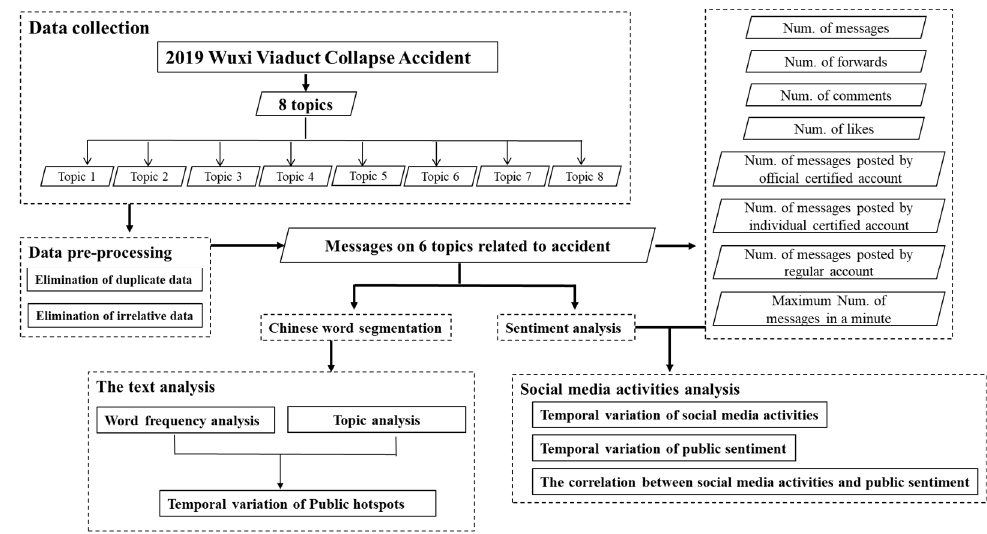
Figure 1. Social media disaster assessment framework and method used for the analysis of the “2019 Wuxi Viaduct Collapse”.